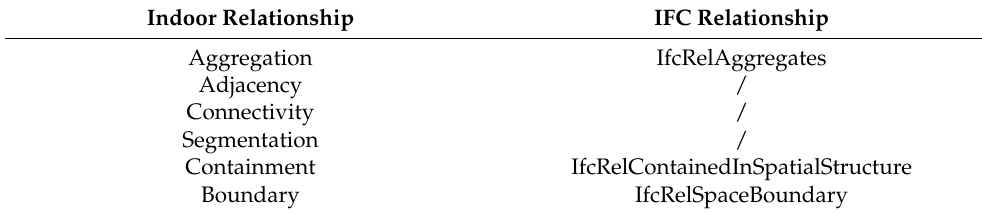
Table 3. Indoor relationship and IFC defined relationship mapping. Indoor Relationship